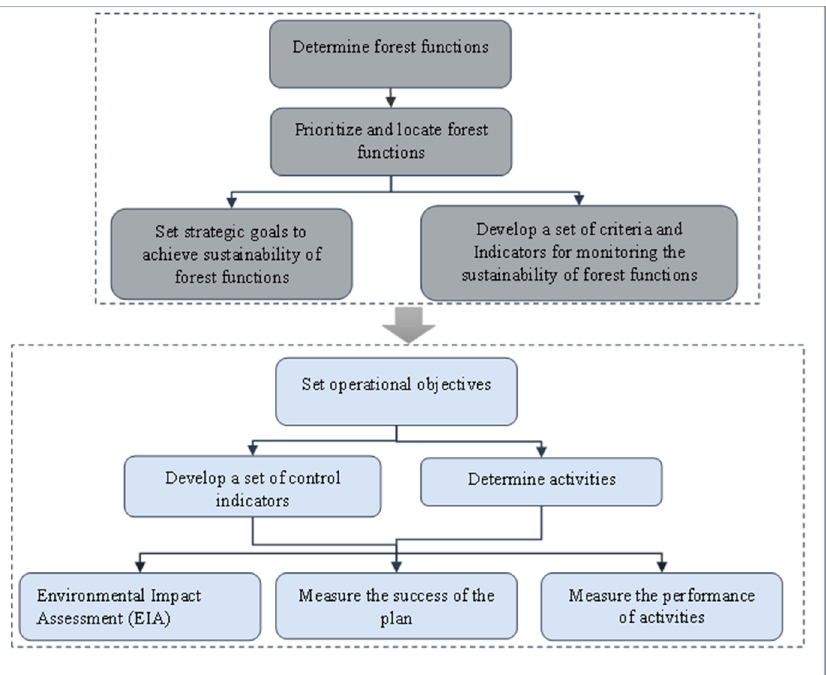
Figure 3. A conceptual model for Hyrcanian sustainable forest management (SHFMM) [31].